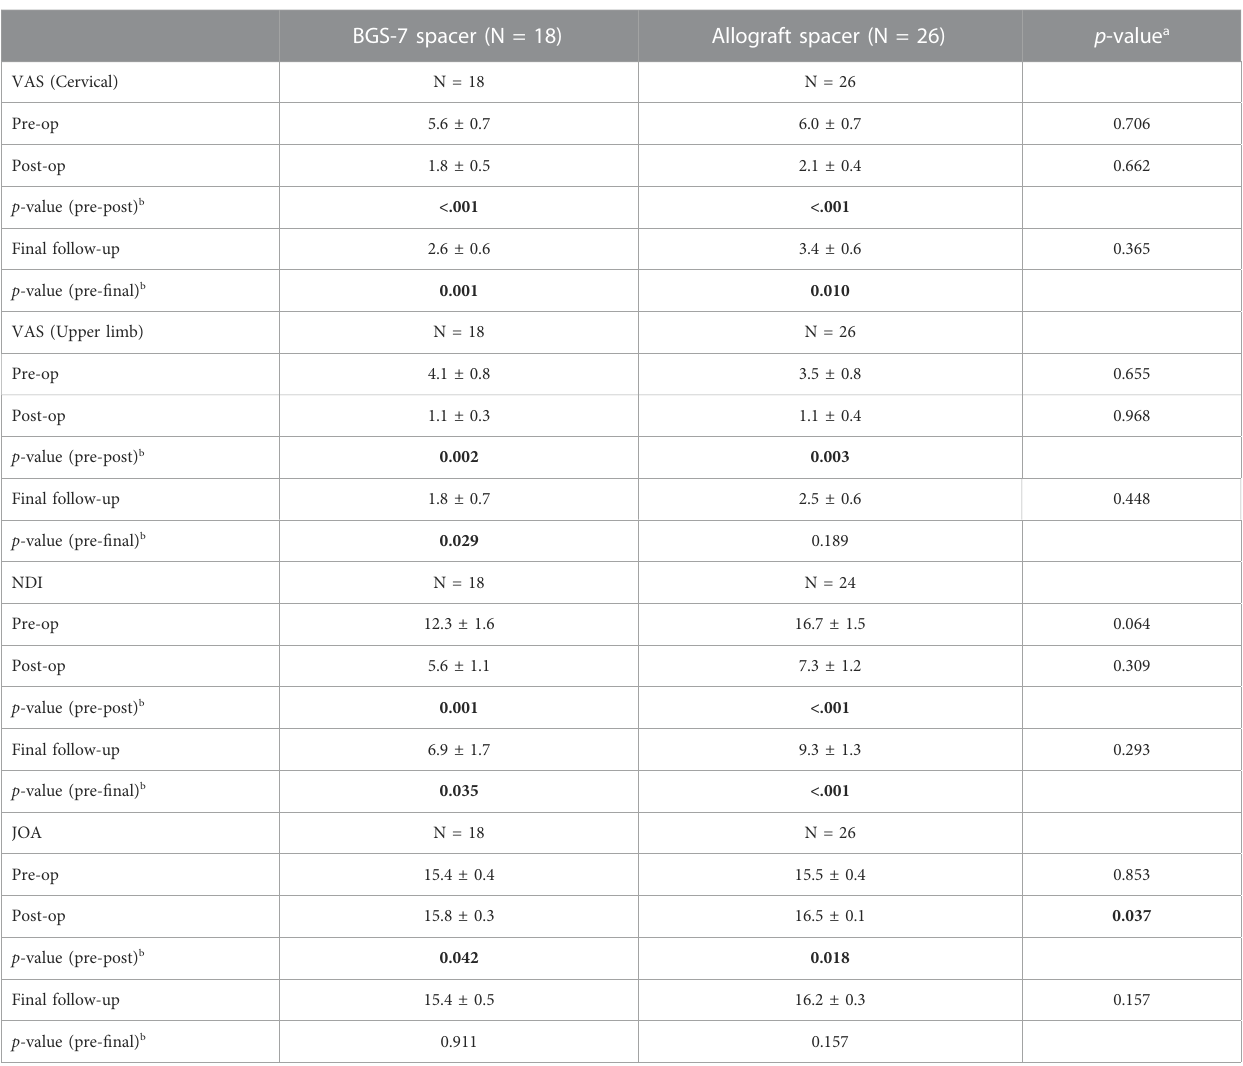
not in the BGS-7 spacer group. However, all of them did not complain of signi fi cant axial pain and the subsidence rate didn ’ t increase over follow up period. No breakage was observed like fracture line or deformation of the BGS-7 spacer on X-ray during